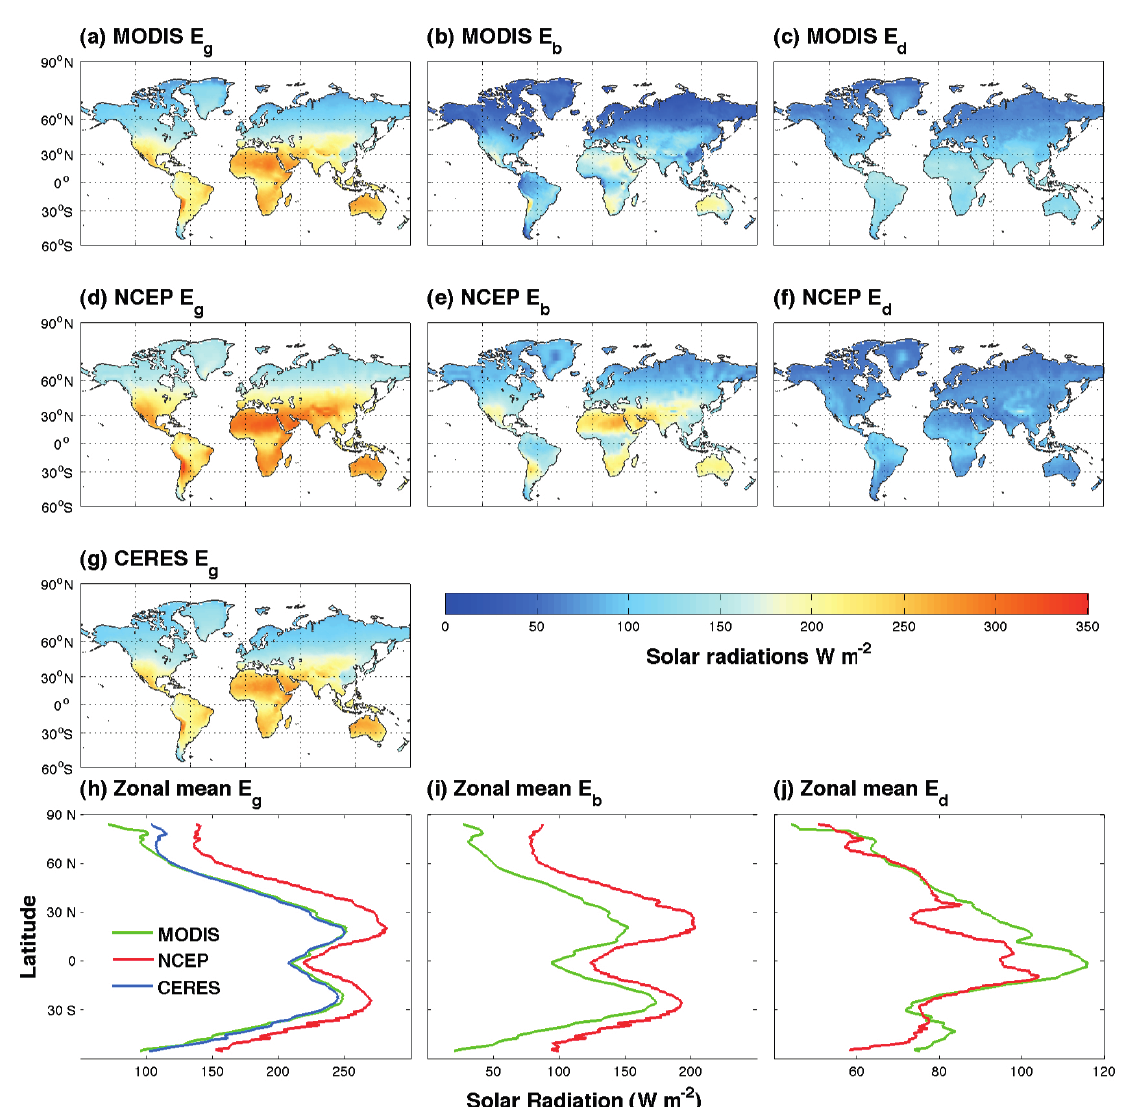
Figure 4. Comparison of the spatial pattern of the MODIS (a–c) , NCEP (d–f) and CERES (g) temporal mean total, direct and diffuse solar radiation over the period 2003–2011. ( h ), ( i ) and ( j ) show the zonal mean of the solar radiation over the global land